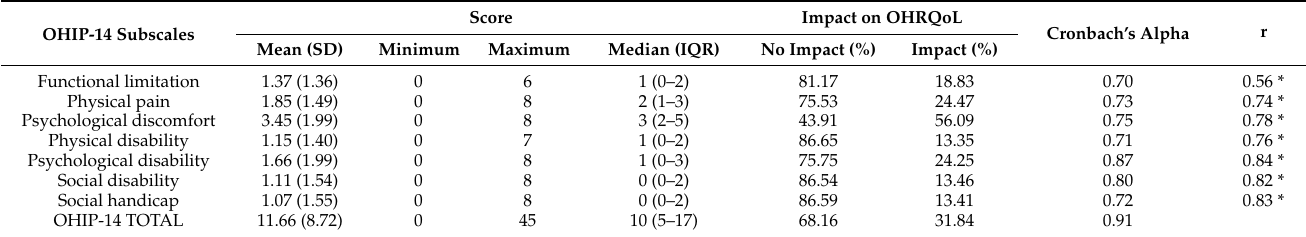
Figure 1. Histogram of the oral health impact profile (OHIP-14) score in the overall study sample (n = 895). Table 1. Descriptive statistics, internal consistency and correlation of OHIP-14 subscale scores and total score among Croatian university students (n = 895).